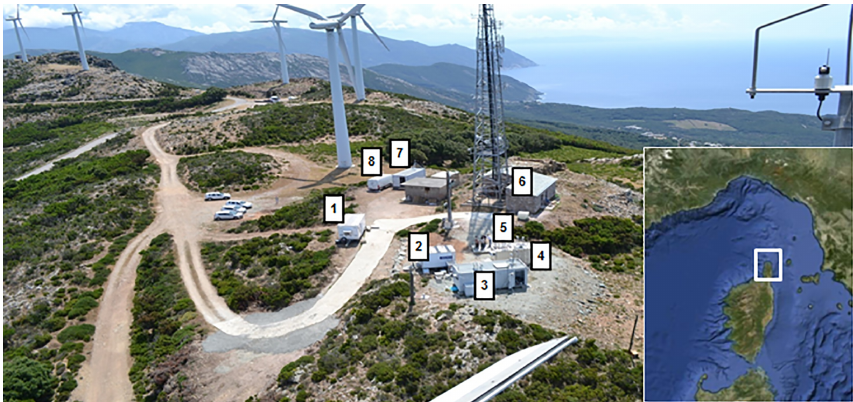
Figure 1. Field site top view, Corsica, France (42.97 ◦ N, 9.38 ◦ E; altitude 533m). Measurements performed: (1) VOCs through PTR-MS and online and offline chromatography; (2) OH reactivity; (3) NO x , O 3 , aerosol composition and black carbon; (4) weather, and particle microphysics; (5) HCHO, trace gases and radicals; (6) CO, CO 2 , CH 4 ; (7) trace gases and particle filters; and (8) particle physics. The photo was taken during the installation of the